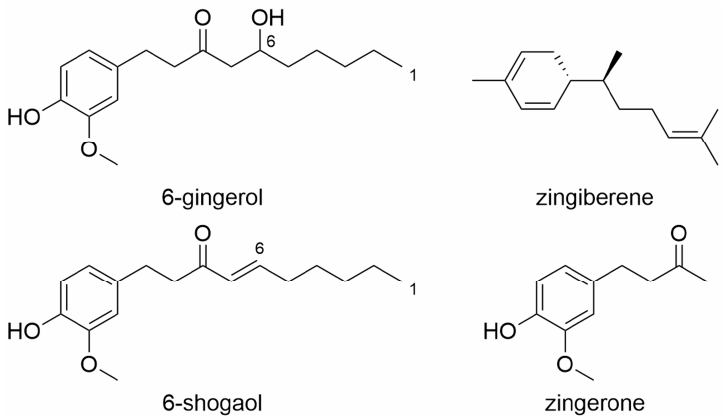
Figure 5. Gingerols and Shogaols from Zingiber officinale (Semwal et al., 2015). 9. Curcumin Curcumin is a secondary plant component of the turmeric plant ( Curcuma longa ). Tur- meric has been used in TCM for various ailments for 2000 years. In 1937, turmeric found its way into modern medicine due to its anti-inflammatory properties [195]. Today, tur- meric can be found in pharmacies and drugstores in powder form, as a liquid preparation, and in the form of capsules or tablets. In addition, the turmeric root is the main component of the curry powder often used in the kitchen. The amount of curcumin in the commer- cially available turmeric root varies between 0.6% and 6.5% of the dry weight [196]. This variance, as well as the poor bioavailability and chemical instability of curcumin (Figure